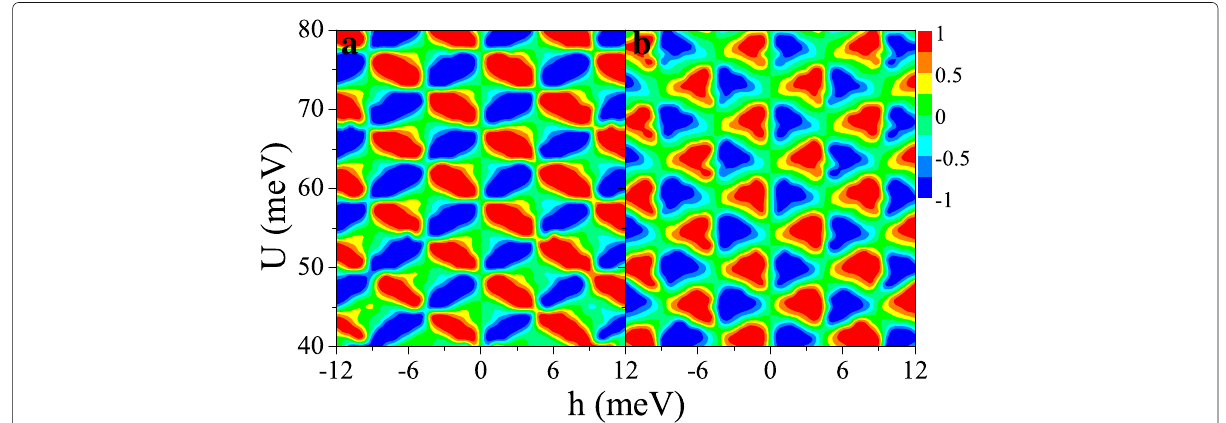
Fig. 9 Contour plot of ( a ) spin polarization P s ( U , h ) and ( b ) valley polarization P v ( U , h ) , at (cid:2) z = 10.0 meV. The values of other parameters are the same as these in Fig.